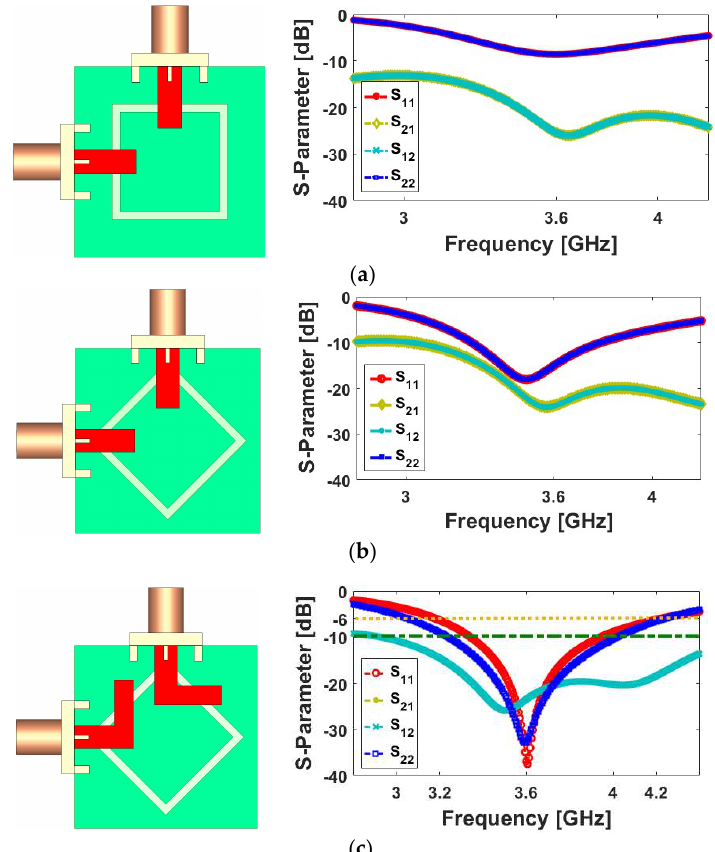
Figure 2. Various structures and S parameter results of: ( a ) square-ring slot with rectangular feed line, ( b ) diamond-ring slot with rectangular feed line, and ( c ) the proposed diamond-ring slot radiator with L-shaped feed line.